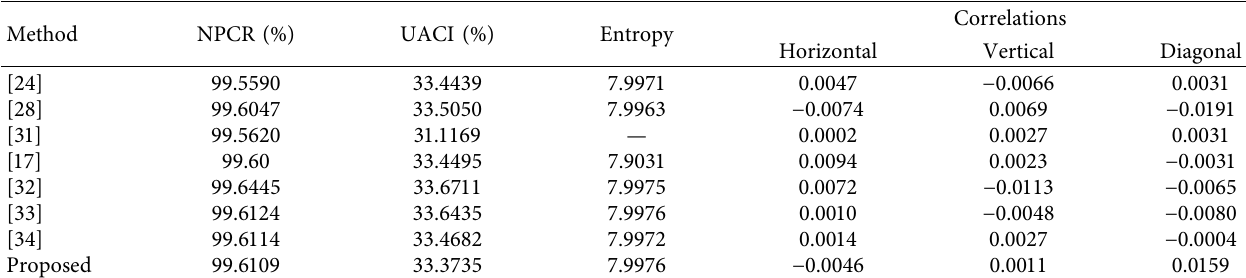
Table 11: Performance comparisons with the existing methods for cameraman image in size 256 ∗